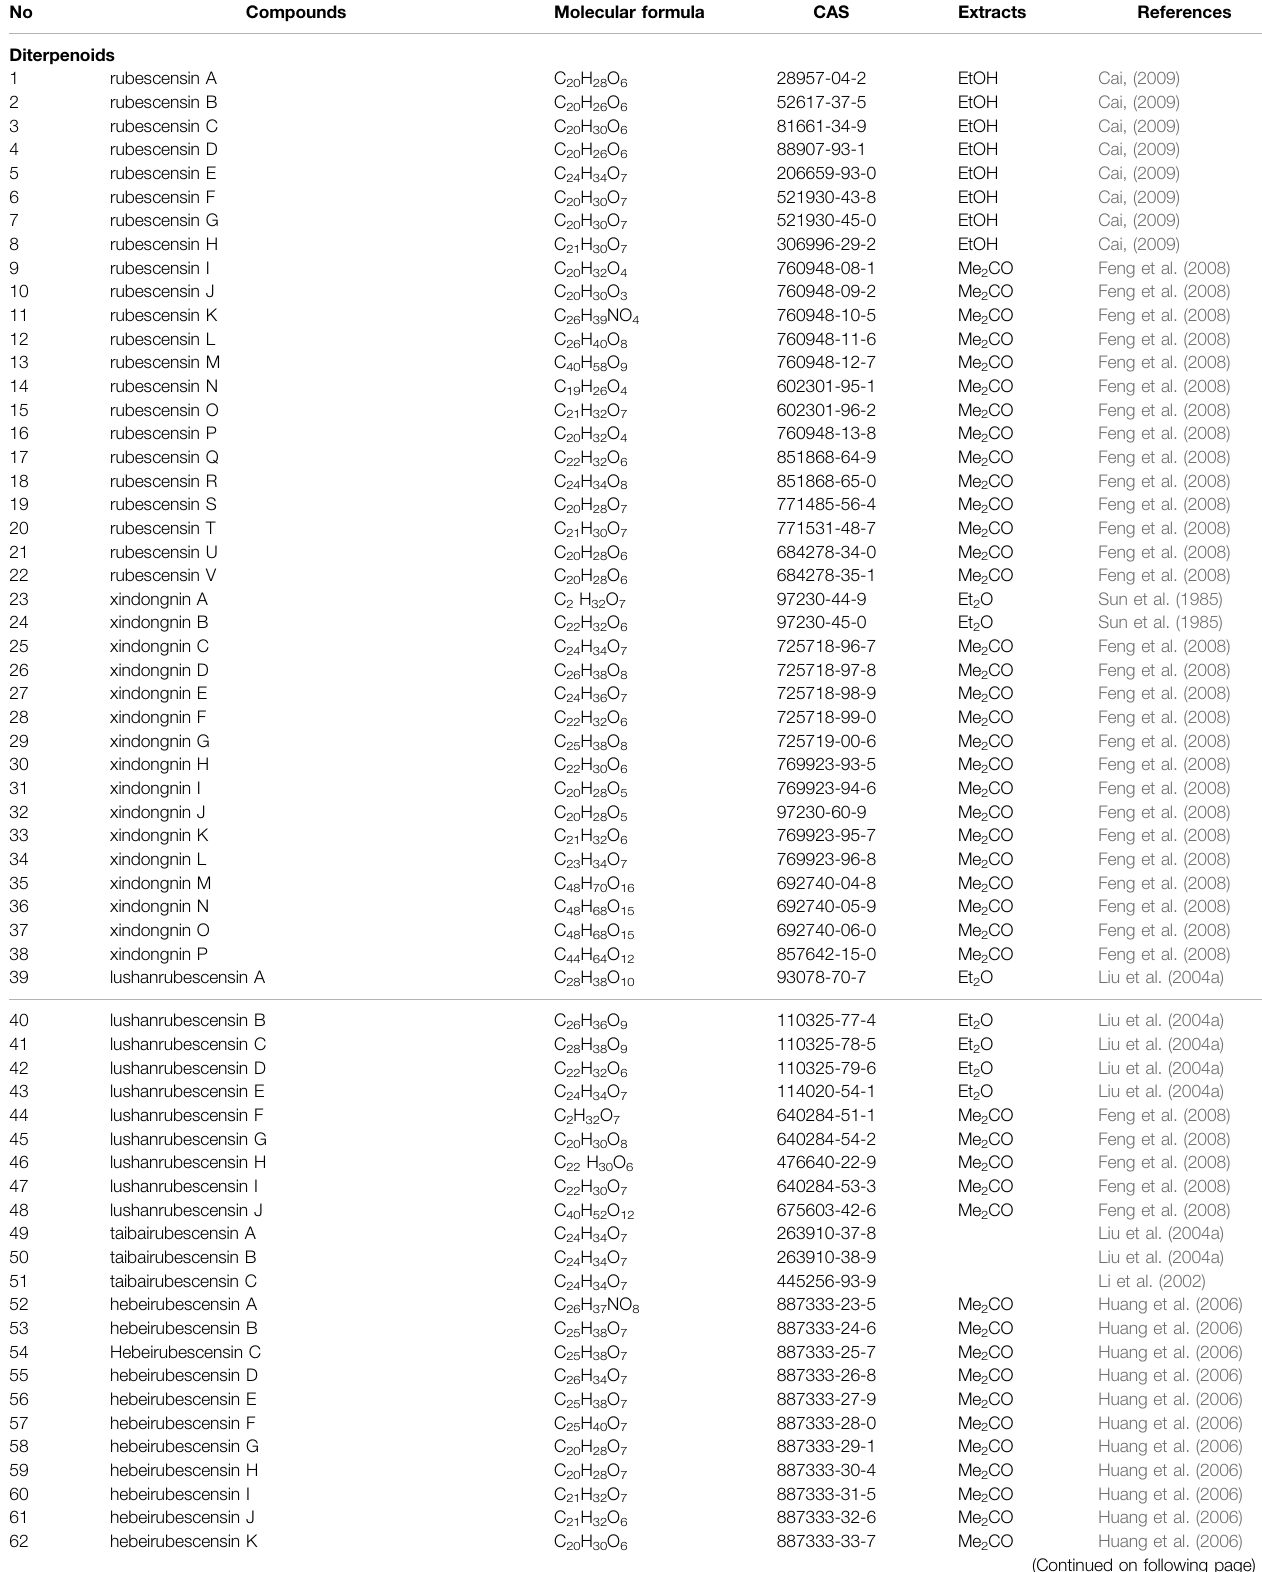
TABLE 2 | The chemical constituents isolated from the I. rubescens . No